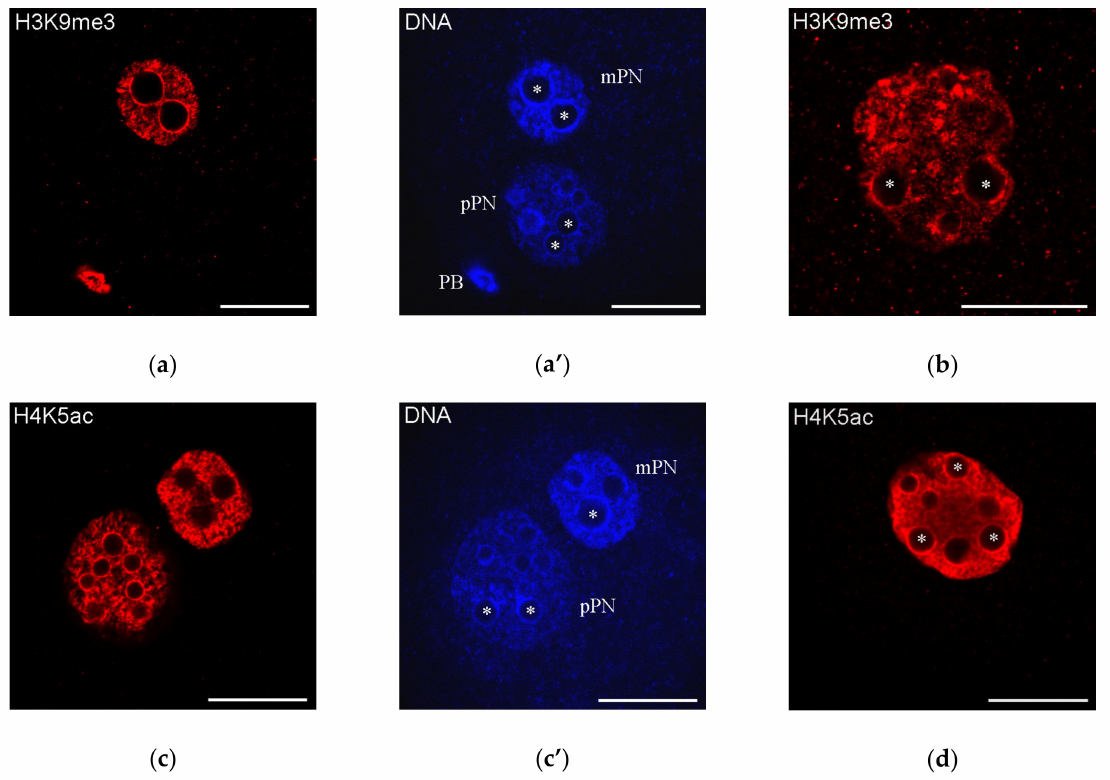
Figure 4. Distribution of H3K9me3 and H4K5ac—the representative marks of “repressed” and “active” chromatin, respectively—in mouse zygotes ( a , c ; a’ , c’ , DAPI staining ) and two-cell embryos ( b , d ); both marks are detected in the heterochromatin rings around nucleolus precursor bodies (some marked with asterisks); mPN, maternal pronucleus; pPN, paternal pronucleus; PB, polar body. Note that H3K9me3 is revealed in mPN but not in pPN. Scale bars represent 20 µ